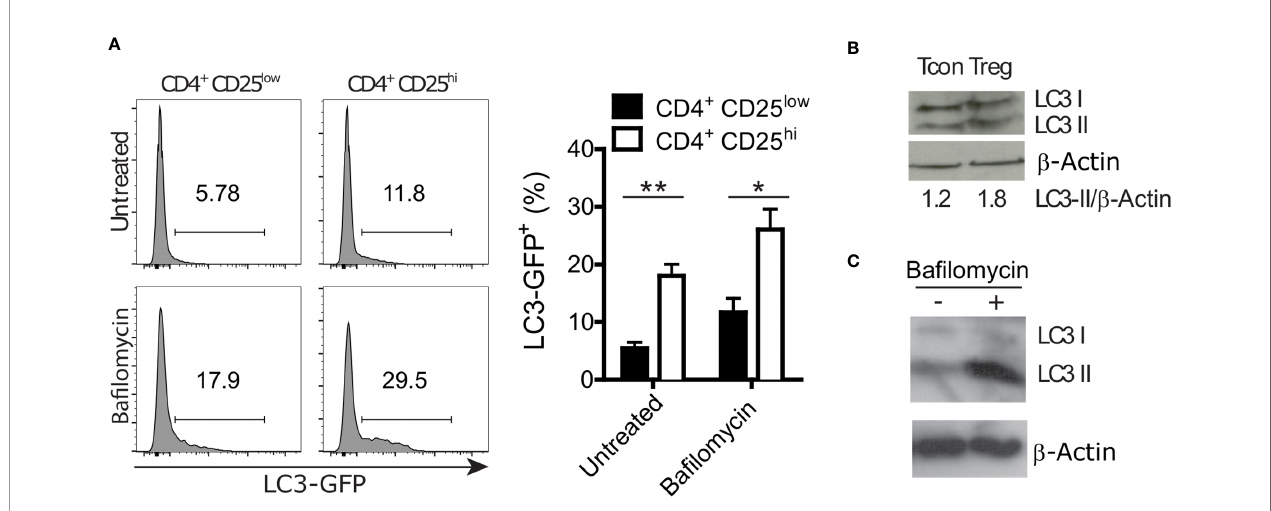
FIGURE 1 | Regulatory T (Treg) cells show a higher autophagy rate than conventional CD4 + T (Tcon) cells. (A) Representative histograms (left) and statistical summary (right) of fl ow cytometric GFP fl uorescence analysis of Ba fi lomycin-treated (2 hours) and untreated CD4 + CD25 low and CD4 + CD25 high lymph node cells (n=5 each) from GFP-LC3 mice. Bar graphs represent the mean ± SEM. Statistical analyses were performed by two-tailed Mann-Whitney tests. (B) Immunoblot analysis of LC3 in FACS-puri fi ed Tcon (CD4 + CD25 low ) and Treg (CD4 + CD25 high ) cells. Numbers show normalized quanti fi cation of LC3 II relative to b -Actin